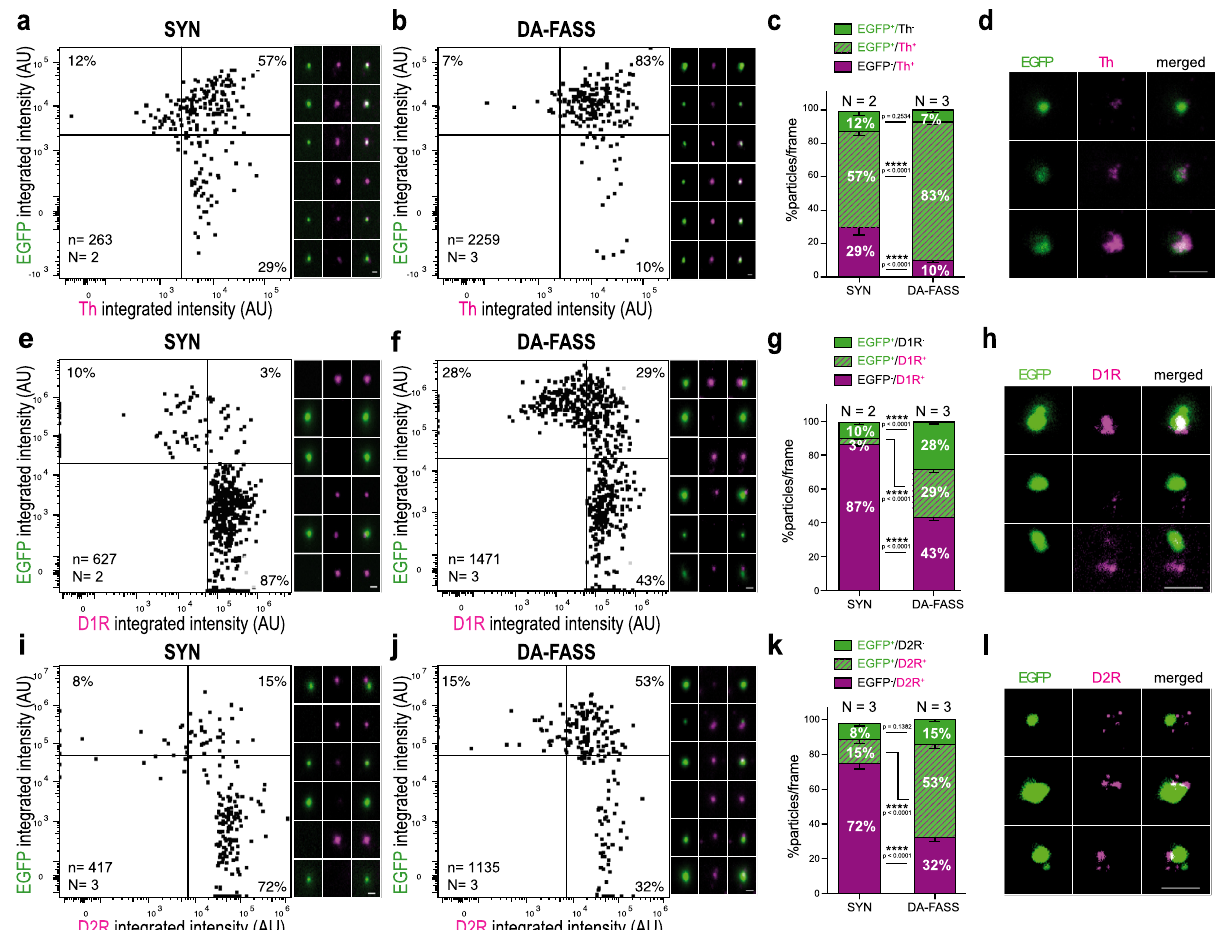
Fig. 2 Immuno fl uorescence analysis of DA-FASS synaptosomes reveal the enrichment for pre- and postsynaptic dopaminergic markers. a , b Epi fl uorescence images of SYN and DA-FASS synaptosomes immobilized on coverslips and immunolabelled with anti-Th and anti-EGFP. Dot plot population analysis of fl uorescence intensities in both channels. c Analysis of staining as in a and b showing particle proportions per frame. d STED images of EGFP (green) and Th (magenta) labelled synaptosomes. e , f Same as a , b for EGFP and D1 dopamine receptors. g Proportion of differently stained particles per frame. h STED microscopy detects D1 receptor clusters (magenta) apposed to the EGFP + synaptosomes (green). i , j Same as a-b for anti- EGFP and anti-D2 dopamine receptors. k Proportion of differently stained particles per frame. l STED images display D2R (magenta) patches apposed to EGFP (green). All data are mean ± SEM and pulled from N = 2 to N = 3 independent sorts and n = 4 to n = 11 fi eld of view per independent sort. Each independent sort pooled at least 3 animals. Statistical signi fi cance was analyzed using Two-way ANOVA; c EGFP/Th: Interaction F 2,96 = 65.04 **** p < 0.0001, Condition F 1,96 = 0.034 p = 0.855, Immunolabelling F 2,96 = 510.3 **** p < 0.0001; g EGFP/D1R Interaction F 2,96 = 208 **** p < 0.0001, Condition F 1,96 = 0.007 p = 0.931, Immunolabelling F 2,96 = 437.9 **** p < 0.0001; k EGFP/D2R: Interaction F 2,180 = 149.4 **** p < 0.0001, Condition F 1,180 = 0.671 p = 0.414, Immunolabelling F 2,180 = 163.5 **** p < 0.0001 with Š ídák ’ s multiple comparisons test. For all panels, scale bar = 1 μ m. See